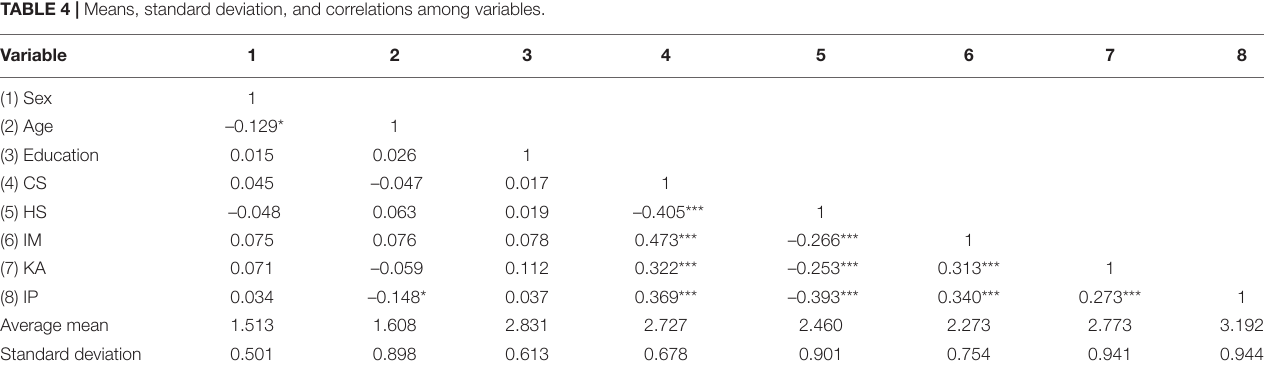
TABLE 4 | Means, standard deviation, and correlations among variables.